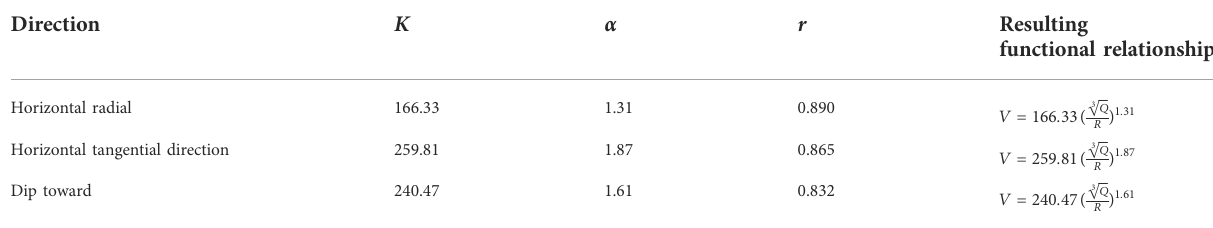
TABLE 5 Results of regression analysis of measured vibration speed. Direction